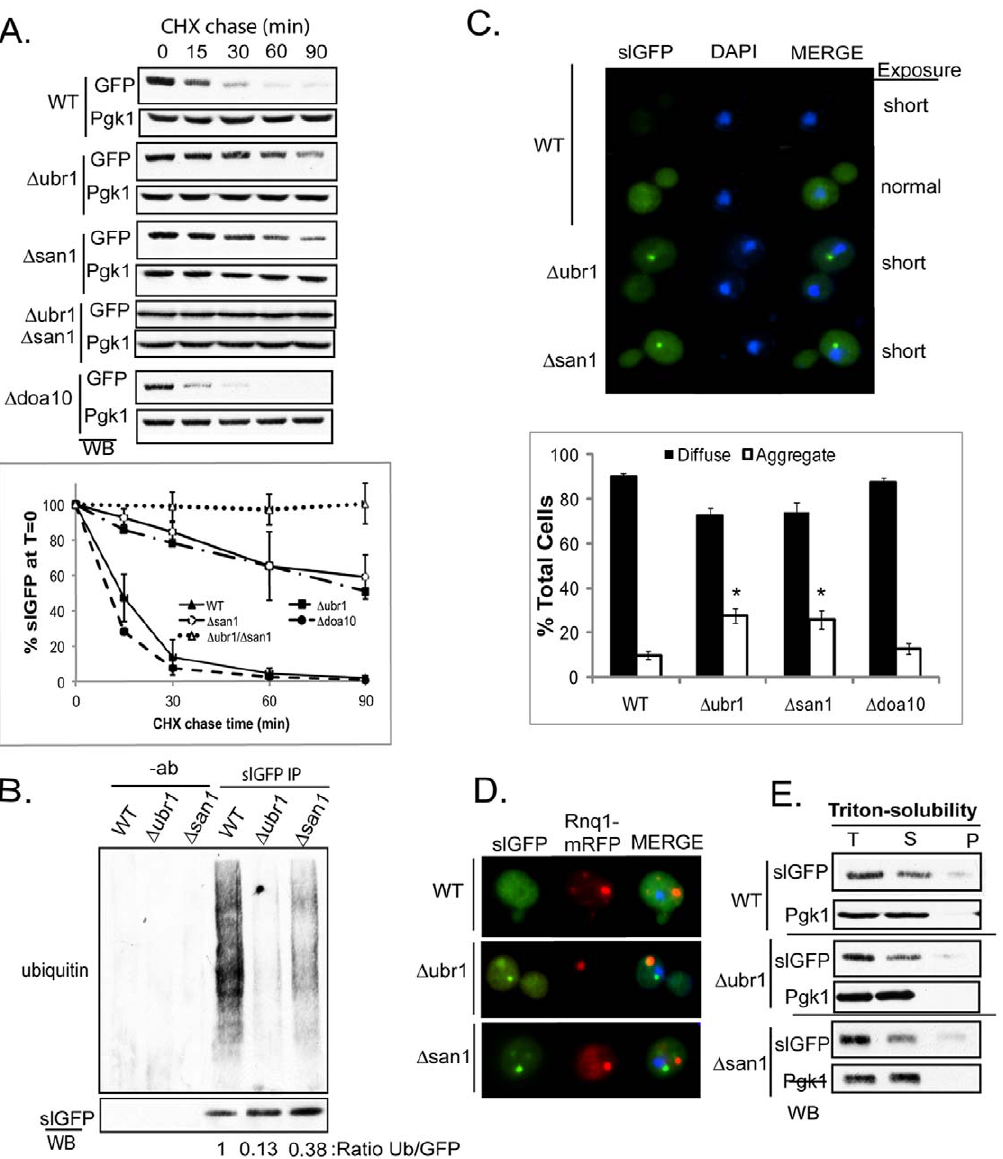
Figure 2. Ubr1 And San1 E3 Ligases Participate In Degradation Of SlGFP. A) Turnover of slGFP in WT, D ubr1 , D san1 or D doa10 was assessed by cycloheximide chase analysis. Quantification of three independent experiments is shown below. B) Ubiquitination of slGFP in WT, D ubr1 , or D san1 . SlGFP was immunoprecipitated from cell extracts and immunoprecipitated material was analyzed by western immunoblotting for ubiquitin. C) Localization of slGFP was analyzed in WT, D ubr1 , or D san1 by fluorescence microscopy. SlGFP fluorescence was notably lower in a WT strain background so a longer exposure was required to compare slGFP localization with D ubr1 or D san1 . Quantification of slGFP puncta in indicated strain backgrounds is shown on the right (*p , 0.05 n=500 cells in three independent experiments). Error bars represent 6 SEM. D) Co-localization of slGFP puncta in WT, D ubr1 , or D san1 strains with Rnq1-mRFP by fluorescence microscopy. DAPI is blue. E) Detergent solubility of slGFP in WT, D ubr1 , or D san1 was assessed after high-speed centrifugation (T-total, S-supernatant,